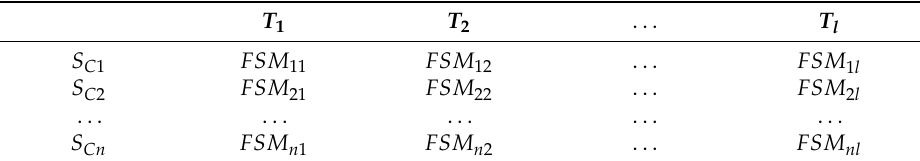
Table 1. Fuzzy sample